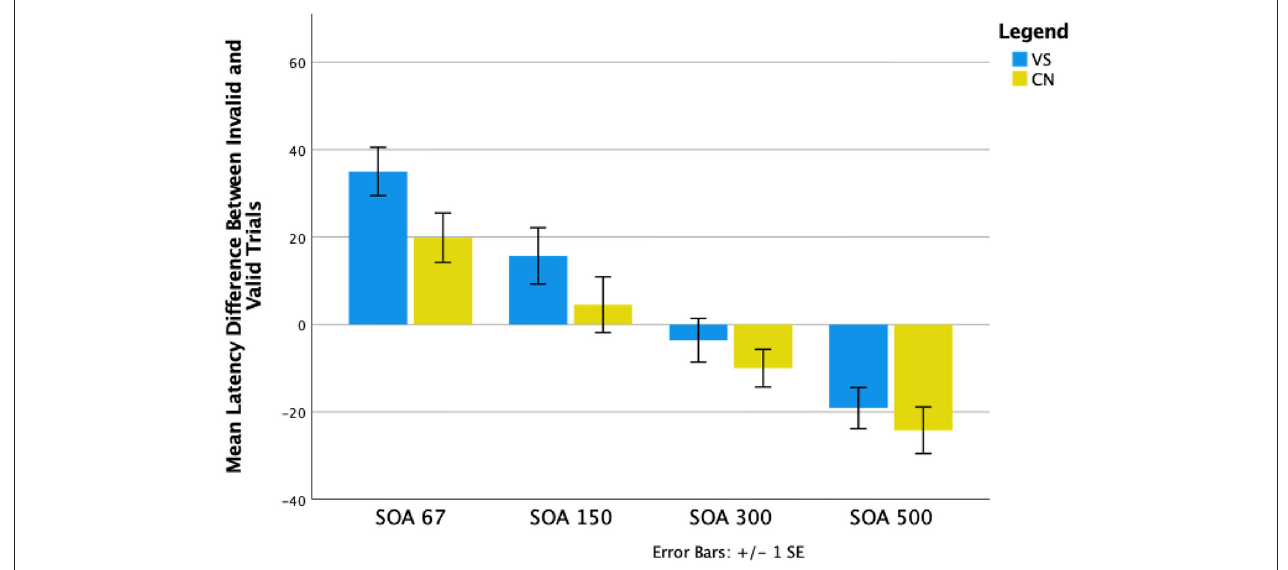
FIGURE 2 | Mean differences between invalid and valid trial types across the four Stimulus Onset Asynchronies (SOAs) for VSS and control